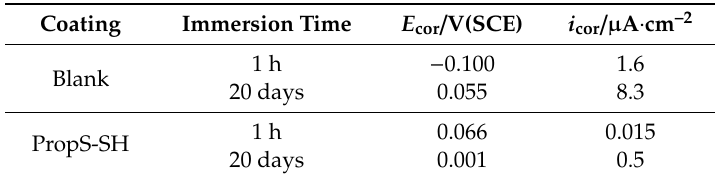
Table 3. Corrosion potentials ( E cor ) and corrosion current densities ( i cor ) obtained on bare and PropS-SH coated bronze electrodes in AR × 10 at 30 ◦ C.